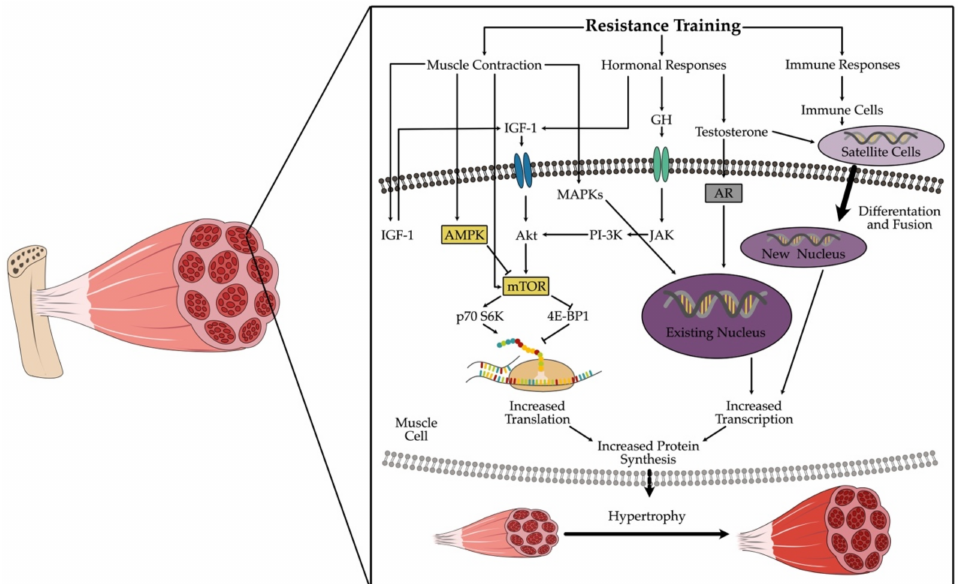
Figure 1. Intracellular adaptions following resistance training and leading to increased protein synthesis. Only the most important steps are pictured, the processes in vivo are much more com- plex. Abbreviations: Akt = protein kinase B; AMPK = adenosine monophosphate-activated protein kinase; AR = androgen receptor; GH = growth hormone; IGF-1 = insulin-like growth factor 1; JAK = janus kinase; MAPKs = mitogen-activated protein kinase; mTOR = mammalian target of rapamycin; PI-3K = phosphatidylinositol-3 kinase; p70 S6K = 70 kDa ribosomal protein S6 kinase; 4E-BP1 = eukaryotic initiation factor 4